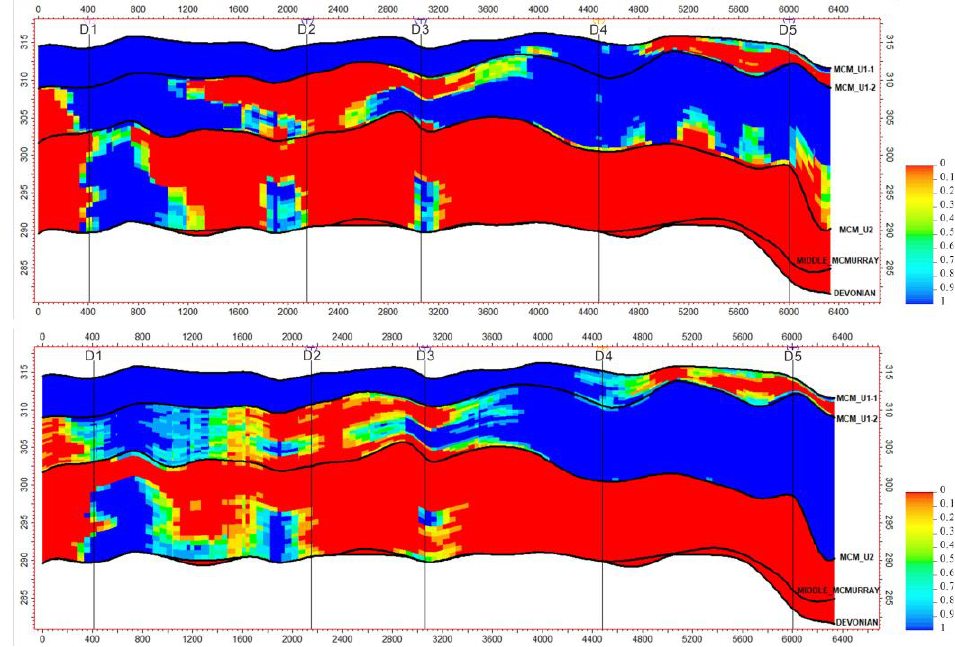
To solve the accuracy of the model, it is a natural choice to increase the number of